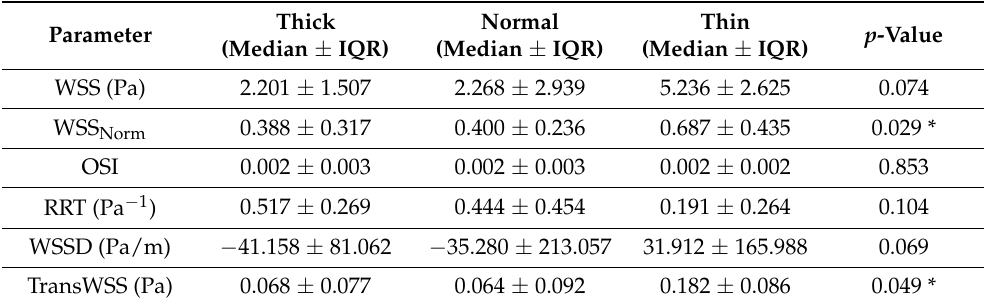
Table 1. Median values and IQRs of different hemodynamics metrics in different wall regions across all aneurysm sacs